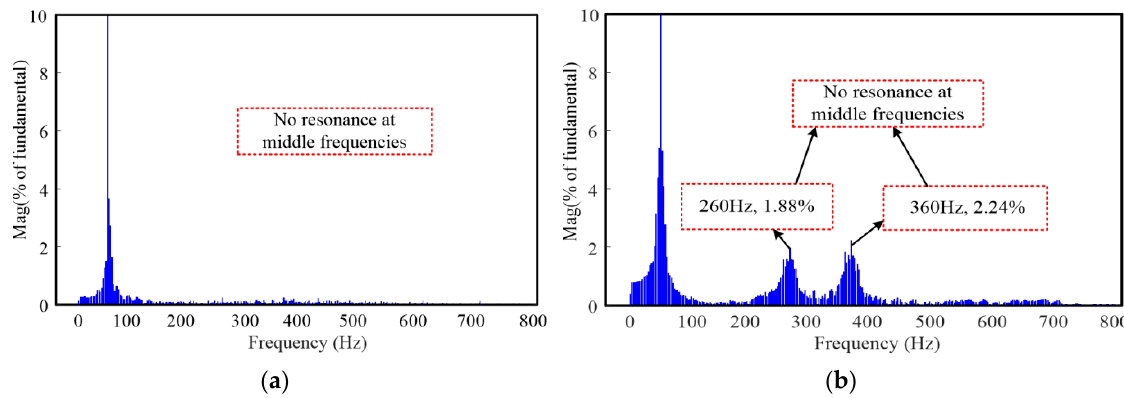
Figure 23. FFT analysis of stator voltage with improved PLL (a) Low bandwidth; and, (b) High bandwidth.